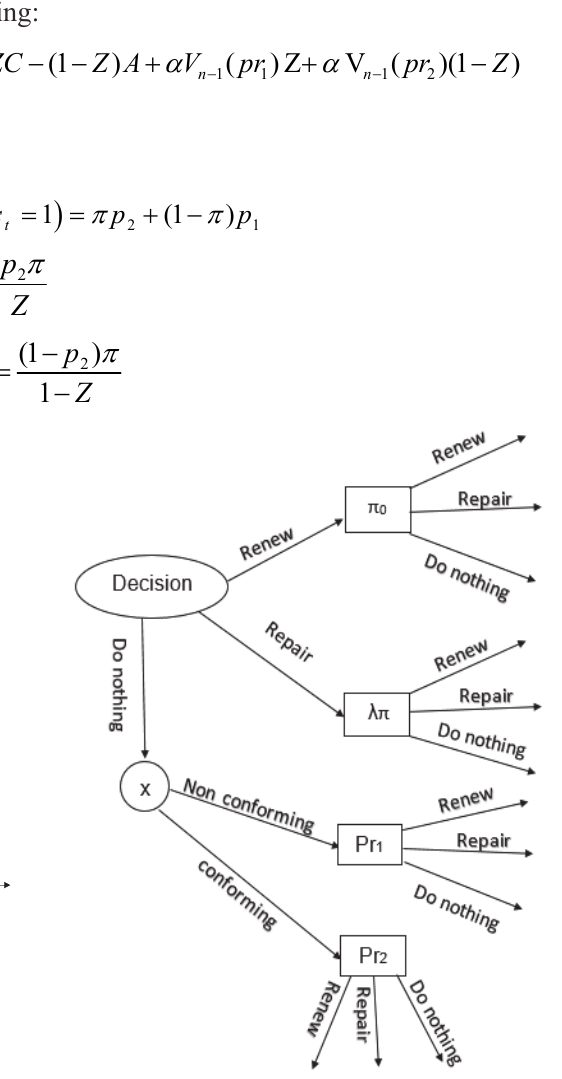
Fig. 4. decision tree which includes the decisions of re- new, repair or do nothing and